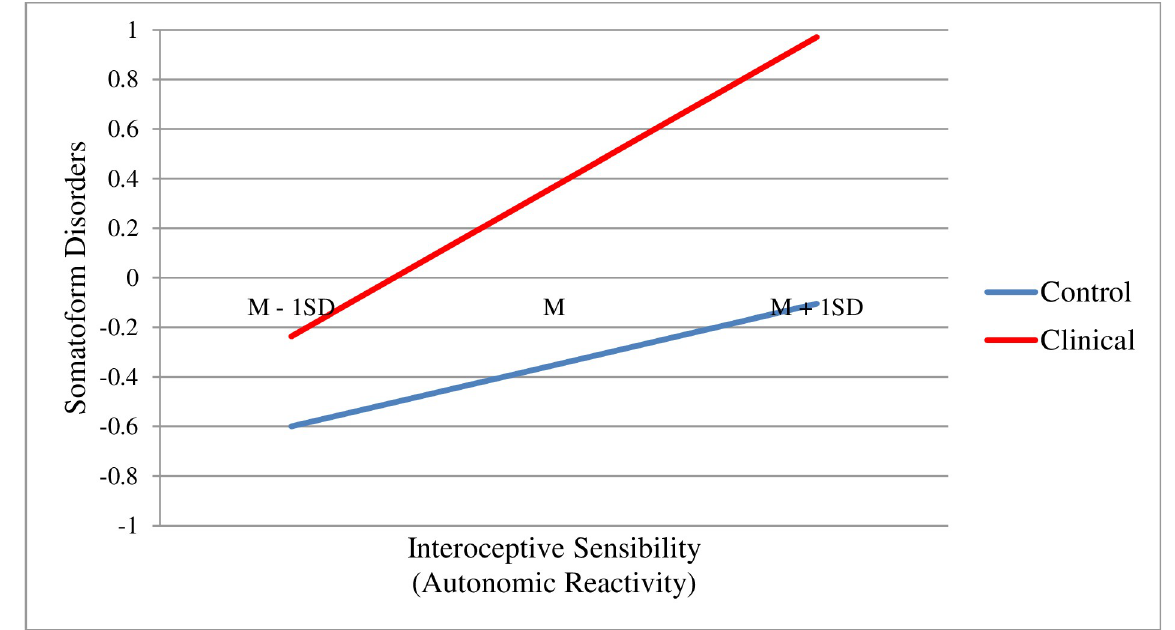
Fig 3. The moderation effect of the clinical and control group on the relation between interoceptive sensibility (autonomic reactivity) and somatoform disorders. Interoceptive sensibility (autonomic reactivity) was measured by Body Perception Questionnaire-Short Form (BPQ-SF). Somatoform disorders was measured by Somatoform Dissociation Questionnaire (SDQ-20).